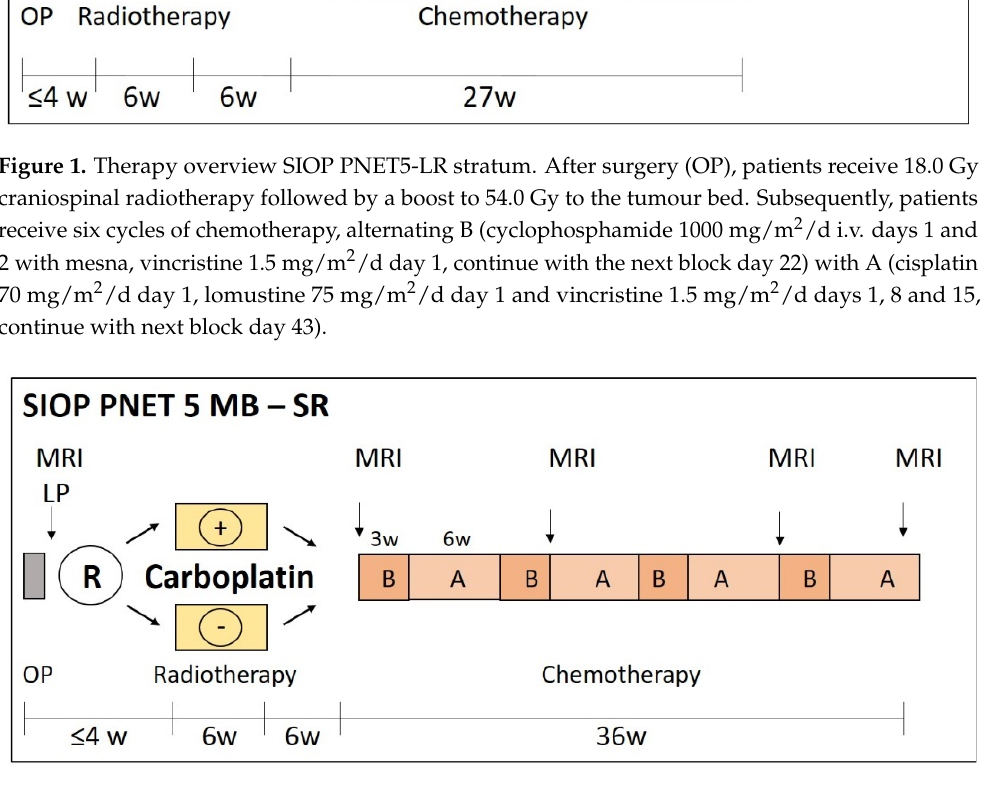
Figure 2. Therapy overview SIOP PNET5-SR stratum. After surgery (OP), patients receive 23.4 Gy craniospinal radiotherapy followed by a boost to 54.0 Gy to the tumour bed. Patients are randomized to receive carboplatin 35 mg/m 2 /d on everyday radiotherapy (i.e., usually 5 days a week). Afterwards, patients receive eight cycles of chemotherapy, alternating B with A (see legend of Figure 1 for drug doses in A and B).